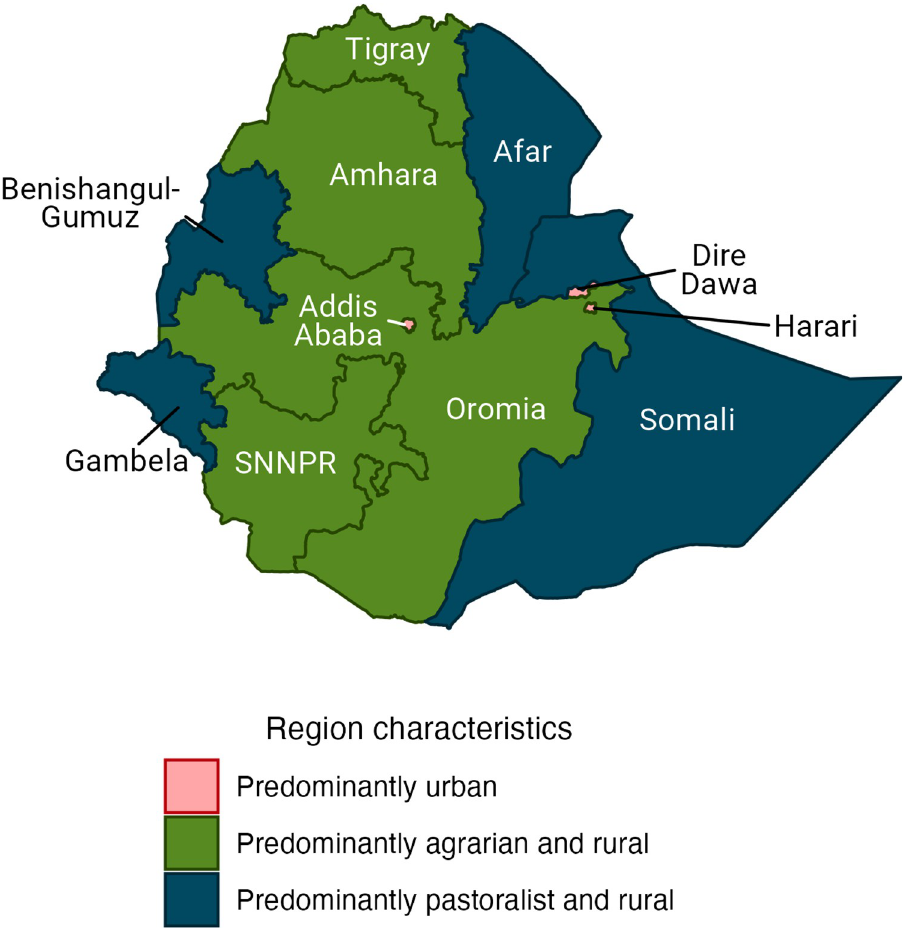
Fig 2. Selected sociodemographic characteristics of Ethiopian regions. Base map data is available from GADM: https://gadm.org/download_country.html.